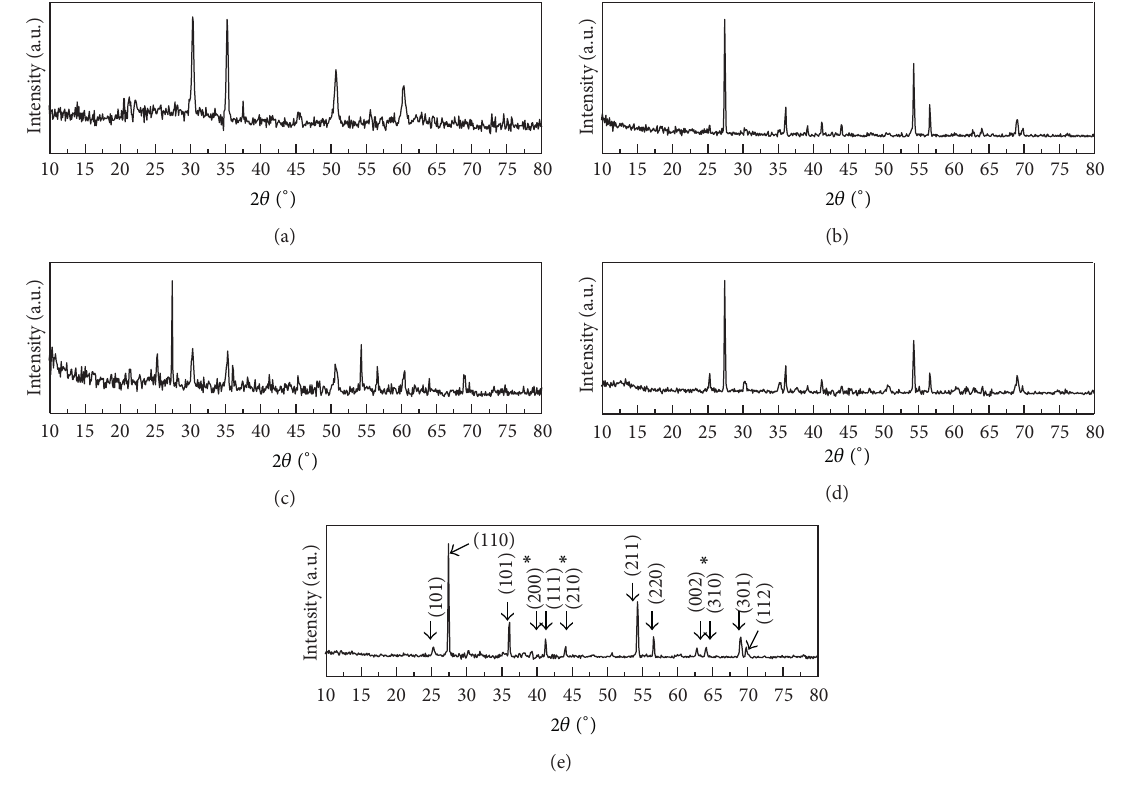
Figure 1: X-ray diffraction patterns of (a) ITO; (b) TiO 2 ; (c) Ag/TiO 2 ; (d) P-TiO 2 ; (e) P-Ag/TiO 2 .